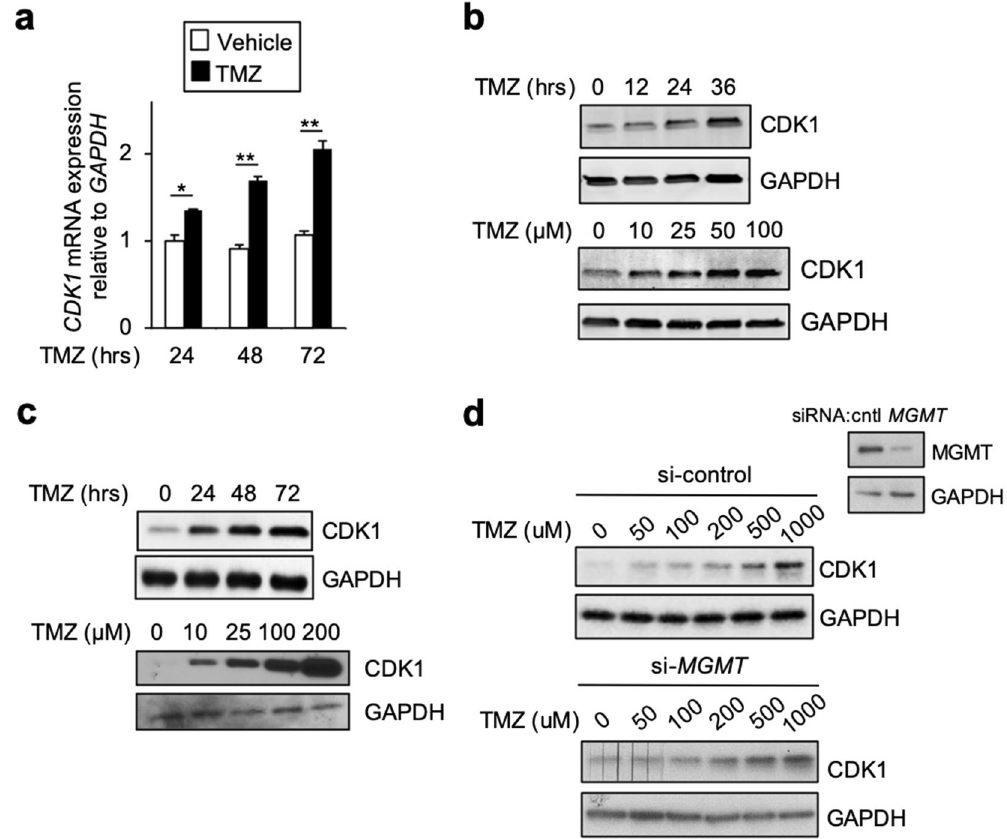
Figure 1. TMZ induces CDK1 expression. ( a ) qPCR analysis of CDK1 mRNA expression in U87 cells at the indicated times following treatment with vehicle or TMZ (100 μM). Data show mean expression relative to GAPDH , ± SD of triplicate samples from three separate biological experiments normalized to vehicle treatment. ( b – d ) Immunoblot (IB) with anti-CDK1 or anti-GAPDH antibody. ( b ) U87 cells treated with 100 μM TMZ for indicated time (top) or with the indicated concentration for 24 h (bottom). ( c ) GBM34 cells treated with 100 μM TMZ for indicated time (top) or the indicated concentration for 24 h (bottom). ( d ) T98 cells expressing either si-control or si-MGMT treated with TMZ for 24 h. Inset: immunoblot with anti-MGMT. IB data representative of duplicate experiments. * P < 0.05, ** P <